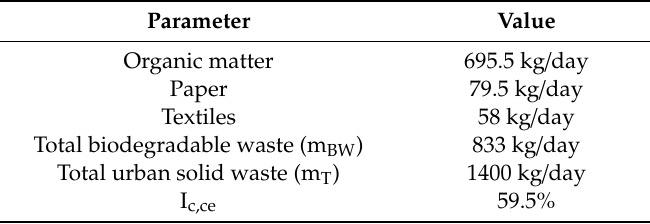
Table 1. Circular economy indicator for composting.